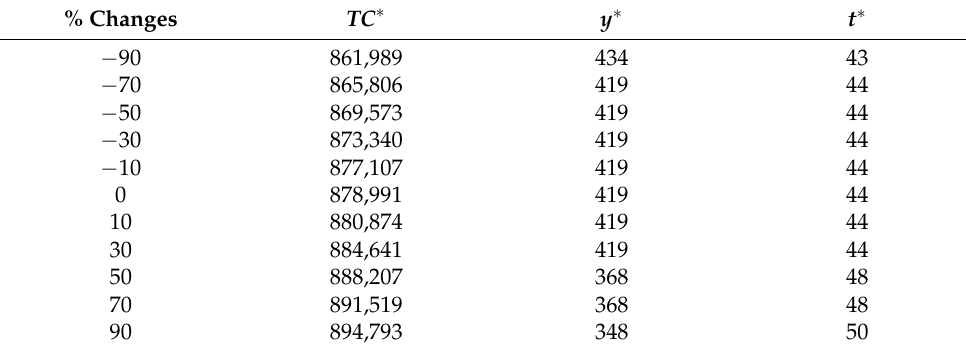
Table 4. Sensitivity analysis of the initial weight ( w 0 ).